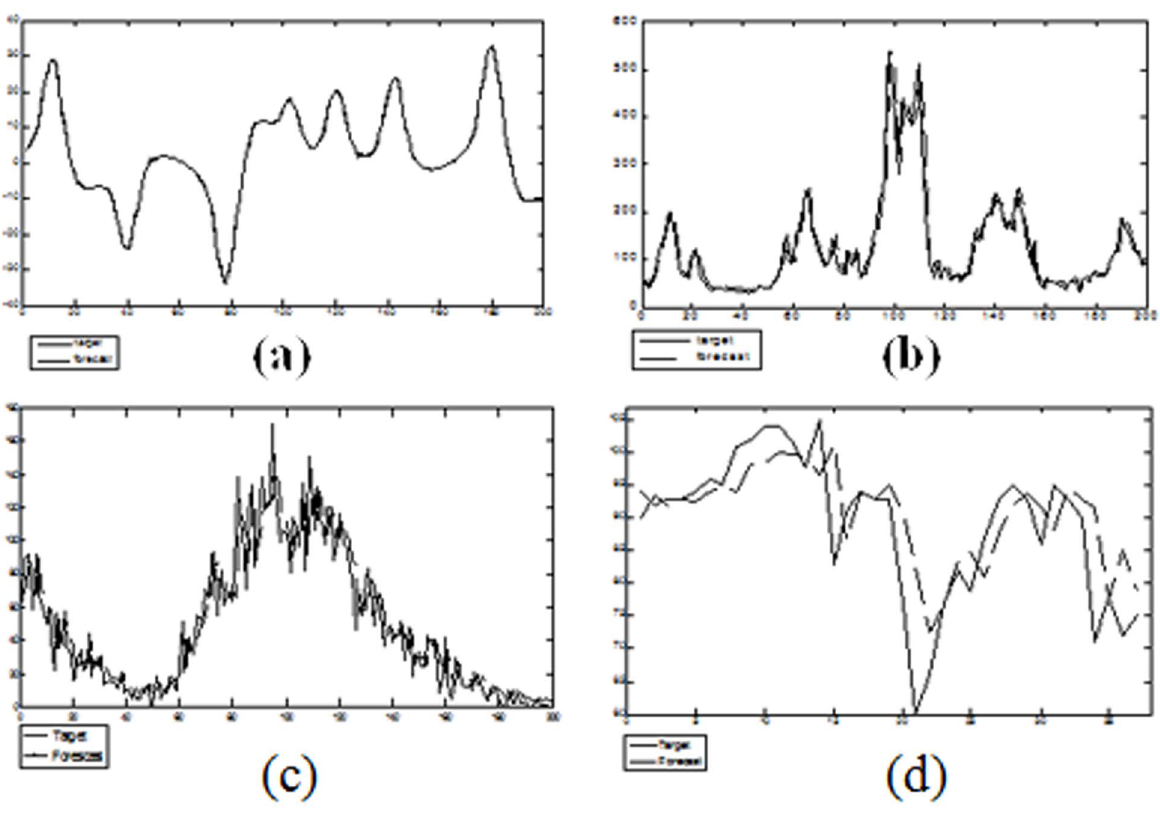
Figure 10. Part of the prediction for the (a) Lorenz attractor time series (b) the mean value of the AE index time series (c) sunspot number time series (d) heat wave temperature time series.